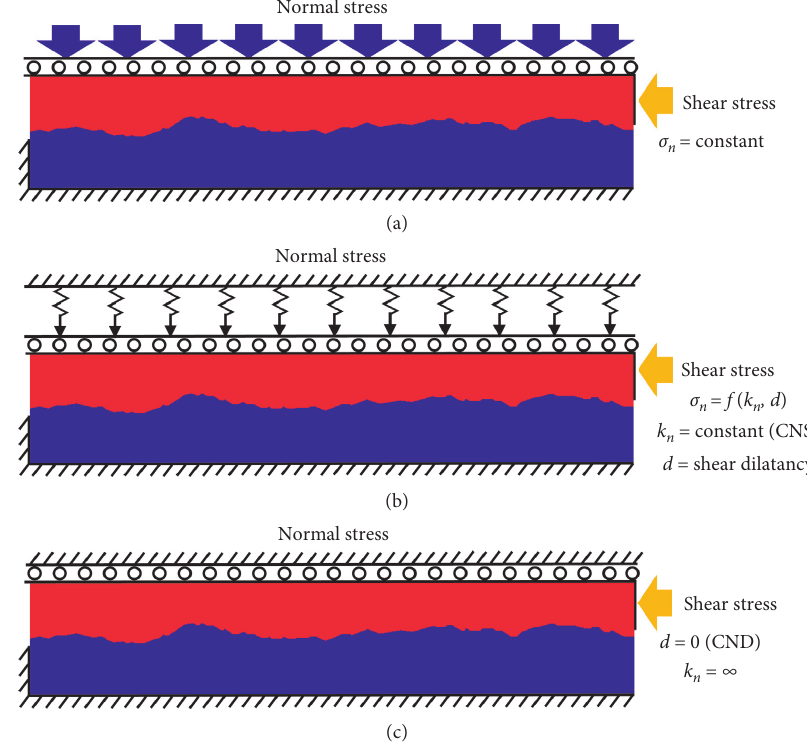
Figure 1: Shear tests under different normal loading conditions: (a) CNL. (b) CNS. (c)